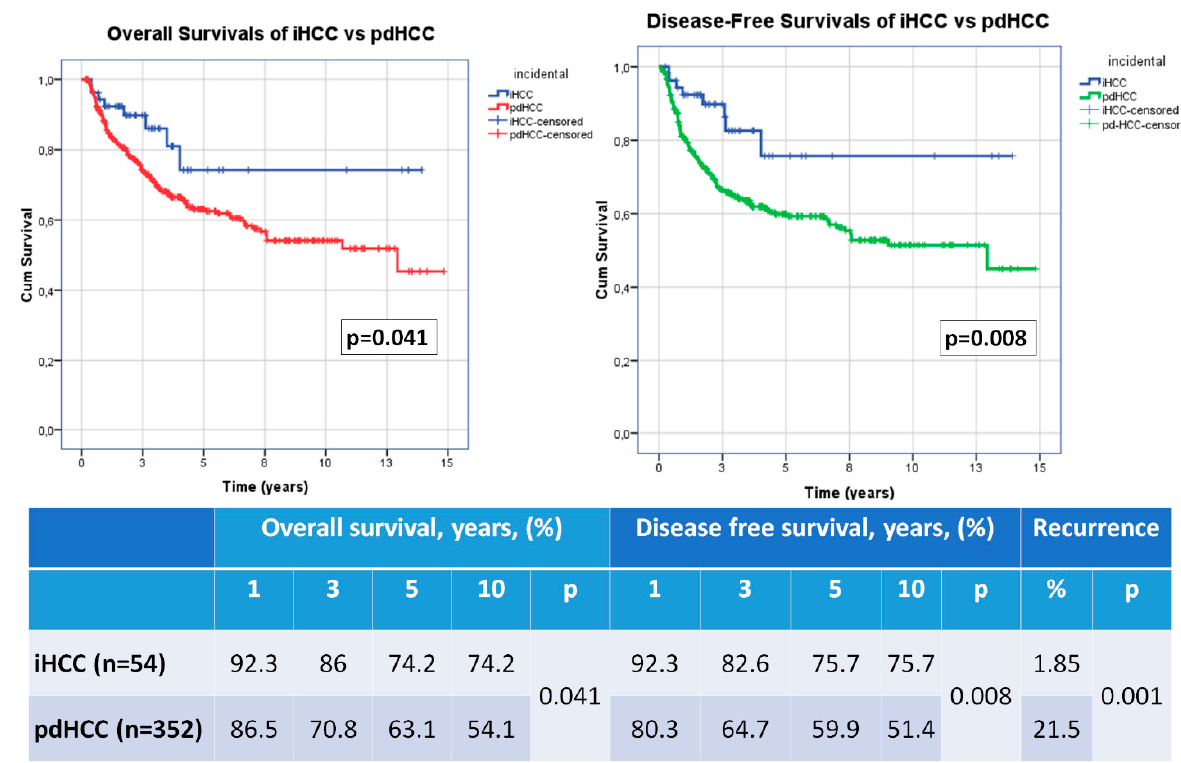
Figure 1. Survival comparison of Hepatocellular carcinoma patients (iHCC vs. pdHCC).